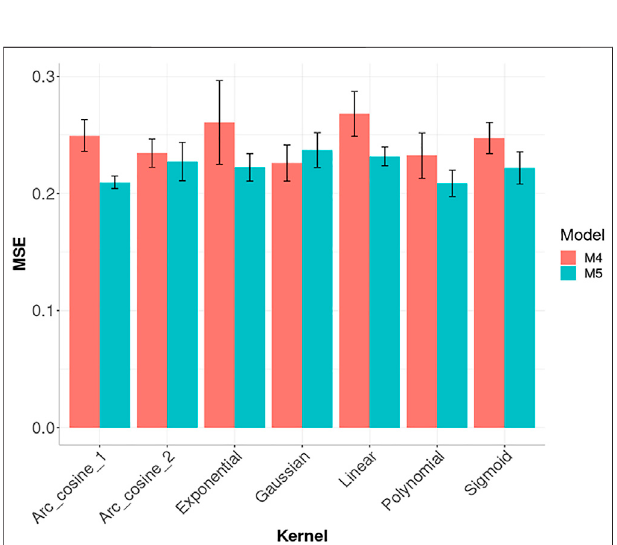
FIGURE 5 | Prediction performance across environments (Global) in Maize data in terms of Mean Square Error (MSE) of models M4 and M5 for sevenkernelmethods. M4denotes the random forest model and M5denotes the Bayesian regression